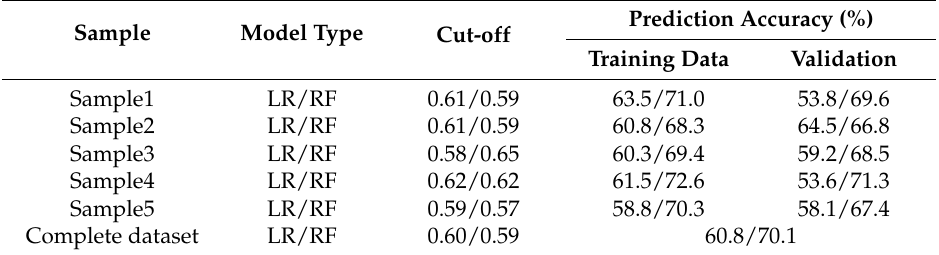
Table 2. Comparison of prediction accuracy and goodness of fit between LR and RF models.